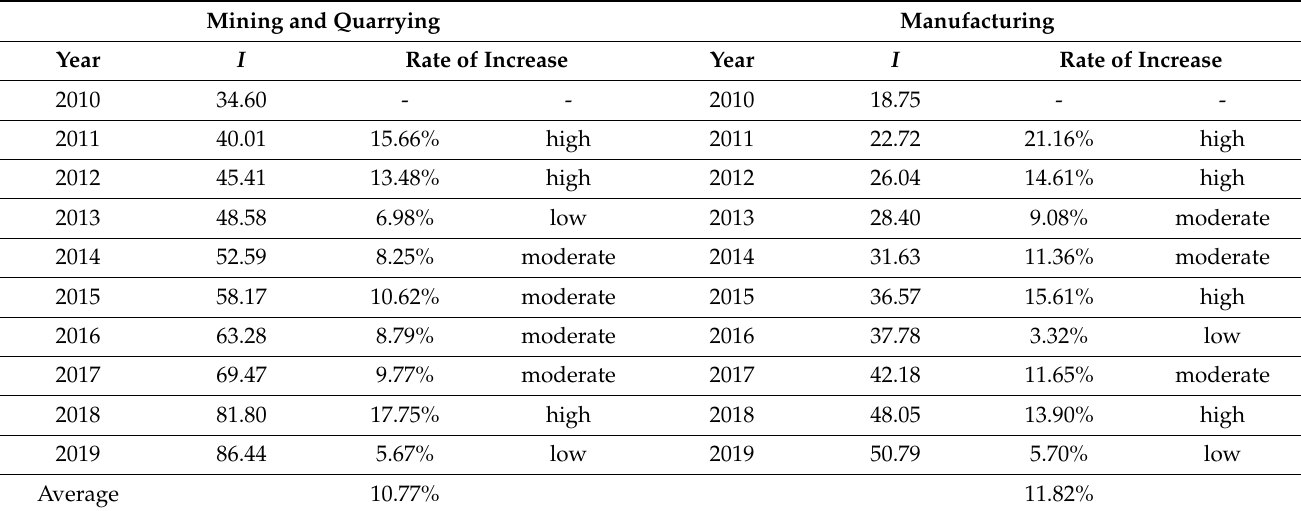
Table 4. Dynamics of the aggregate indicator of sustainable industrial